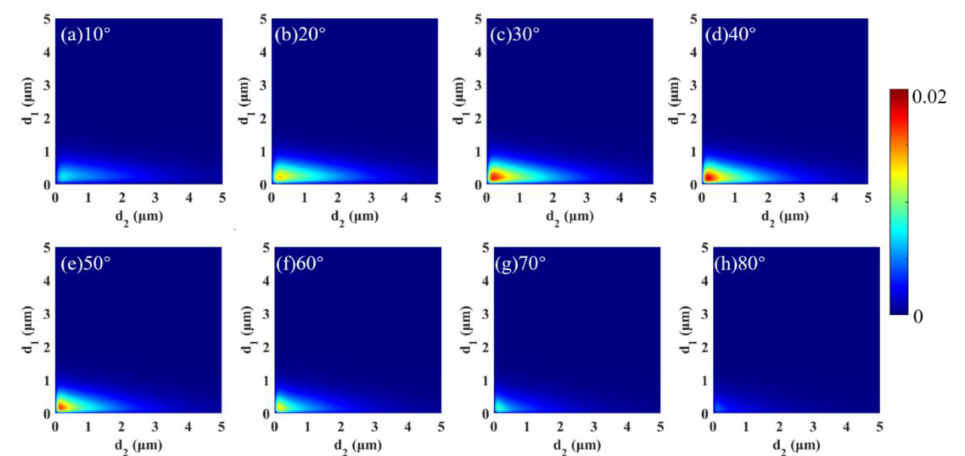
Figure 2. When the wavelength was fixed at 12 µ m, and f = 0, CD varied with d 1 and d 2 for different rotation angles: ( a ) 10 ◦ , ( b ) 20 ◦ , ( c ) 30 ◦ , ( d ) 40 ◦ , ( e ) 50 ◦ , ( f ) 60 ◦ , ( g ) 70 ◦ and ( h ) 80 ◦